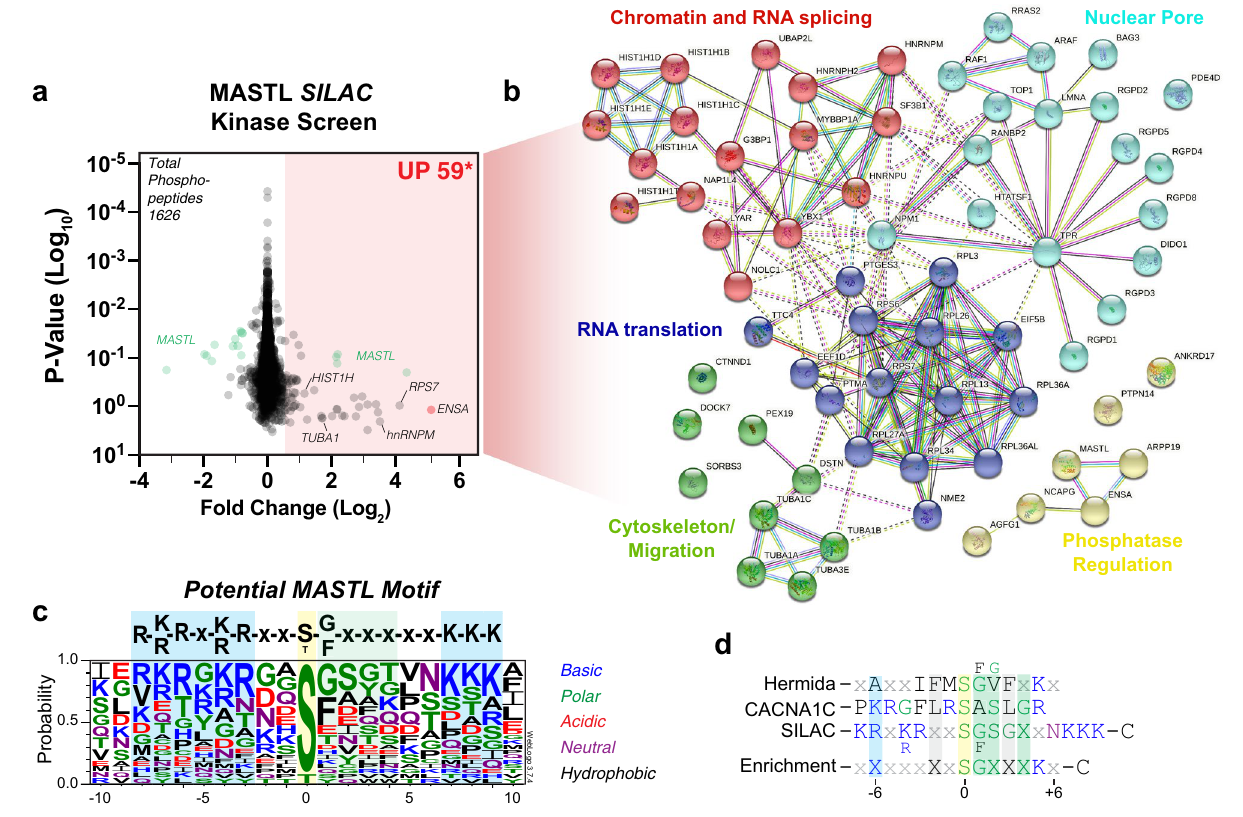
Figure 2. MASTL SILAC kinase screen. (a) Volcano plot of all identified phospho-peptides identified from the MASTL SILAC kinase screen. A minimal Log 2 Fold change cut-off < 0.5 (red shading) was taken as potential increased phosphorylation events. (b) STRING 49 cluster analysis of proteins corresponding to increased phospho-peptides identified in a. (c) Phospho-peptides with a Log 2 Fold change > 1.0 were aligned using WebLogo v3.7.4 52 . Residue colors indicate chemical properties of amino acids. (d) Alignment of top phosphorylated peptide (CACNA1C) from the S/T/Y Physiological Kinase Substrate Finder Assay (Reaction Biology), with the potential MASTL motif identified in